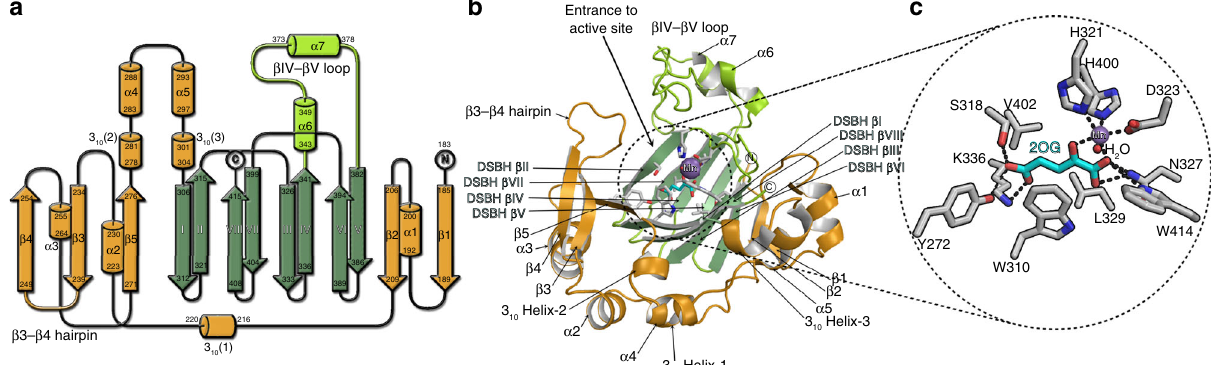
Fig. 2 Overview of the JMJD5 structure. Topology ( a ) and ribbon representation ( b ) of the JMJD5.Mn.2OG complex and the active site close-up ( c ) (PDB: 6F4S). DSBH secondary structure elements are labelled I – VIII (green). The JMJD5 fold contains 7 α -helices, 13 β -strands and 3 3 10 helices. The N-terminal domain preceding the DSBH is in orange and the remainder of the structure, including the DSBH β IV – V insert, in light green. 2OG is shown by cyan sticks and the metal by a purple